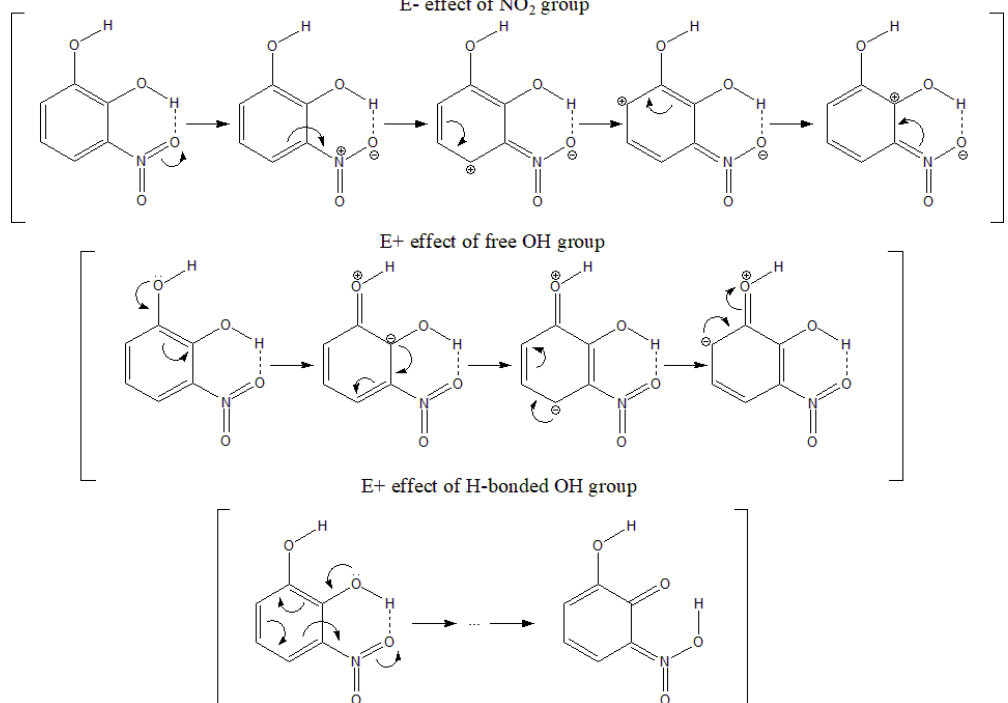
Figure 6. Electromeric effects of NO 2 and OH substituents from the 3NCAT molecule.